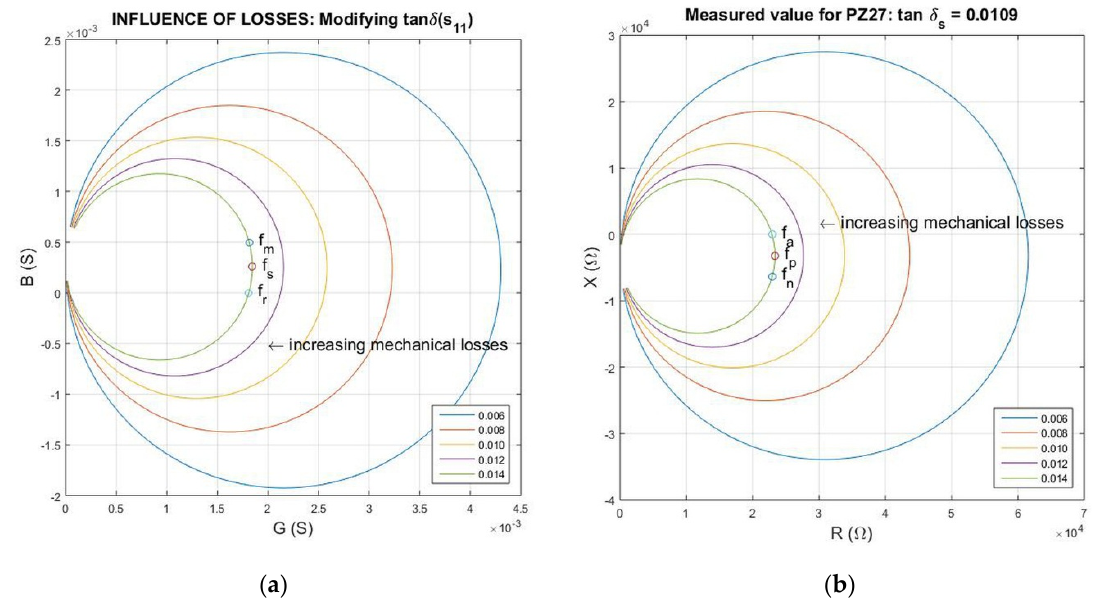
Figure 3. ( a ) G ‐ B and ( b ) R ‐ X plots showing the “position” of the three possible resonance frequencies (in the G ‐ B plot): f r , zero reactance; f s , maximum conductance; f m , maximum absolute admittance; and the three possible anti ‐ resonance frequencies (at R ‐ X plot): f a , zero susceptance; f p , maximum resistance; f n , maximum absolute impedance.